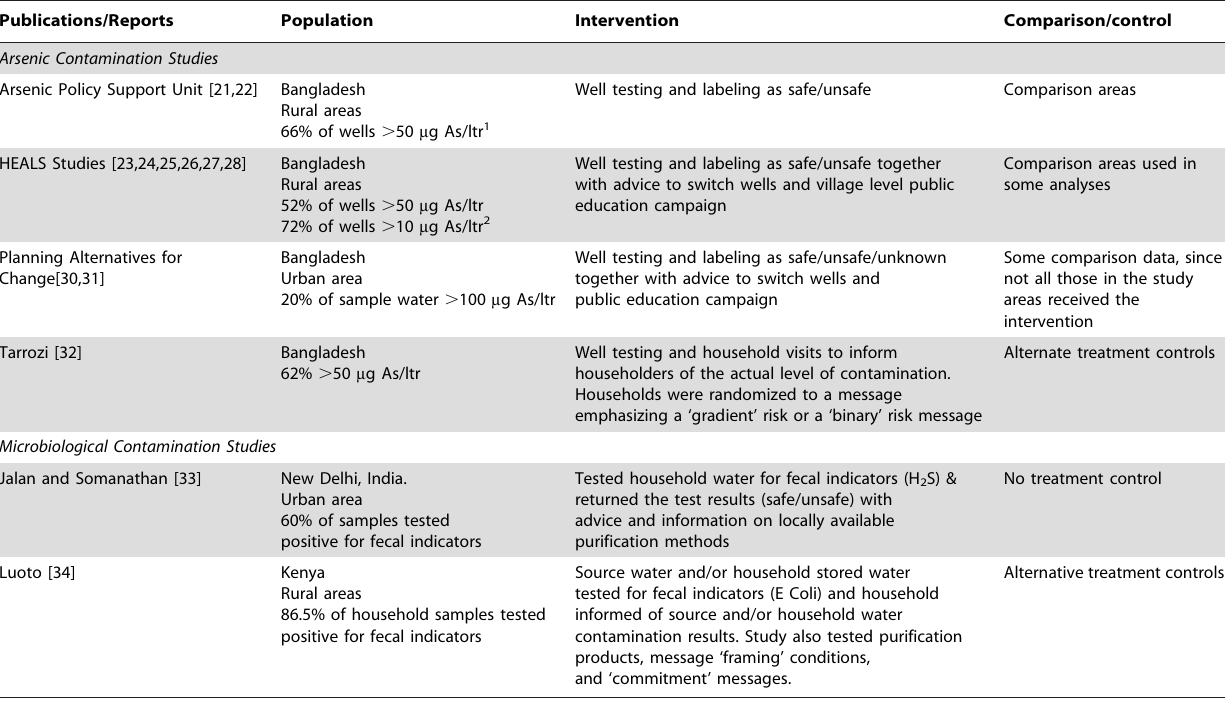
Table 1. Characteristics of Included